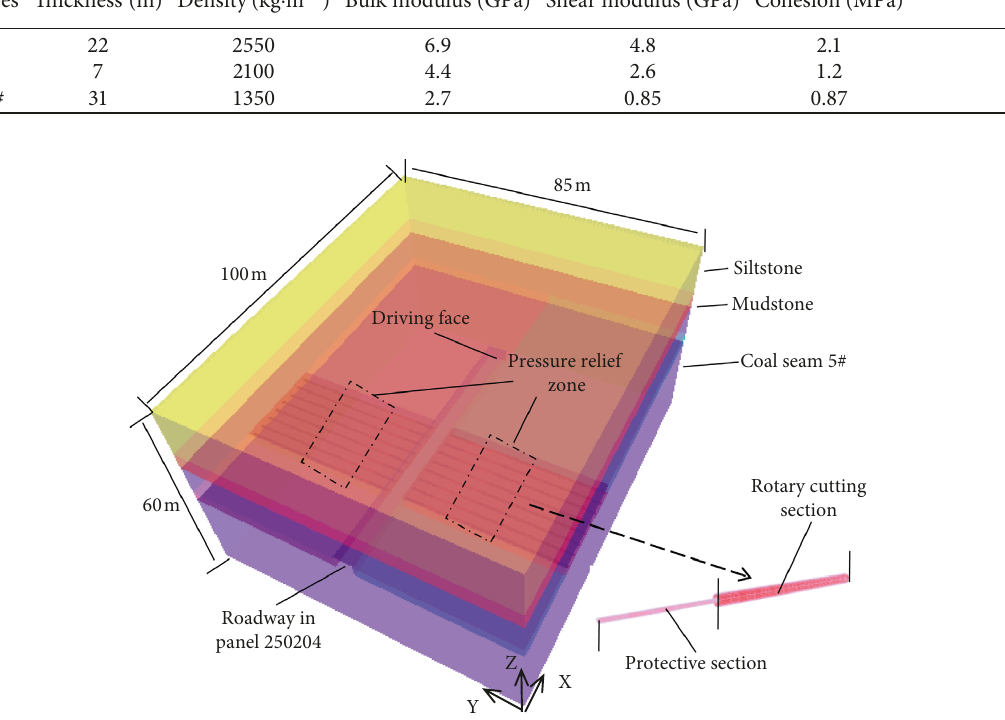
Figure 13: The 3D model established by FLAC 3D numerical software.